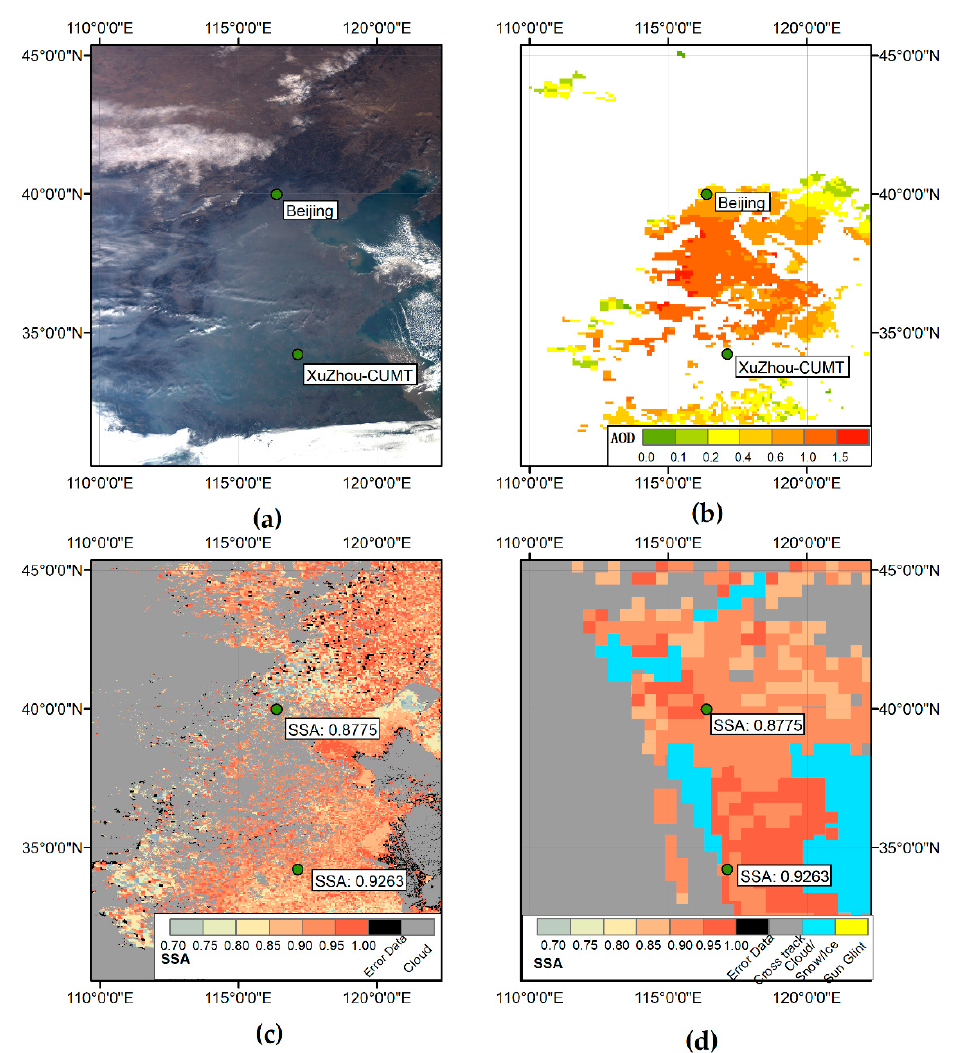
Figure 11. ( a ) True color composite map from MODIS (data came from Terra in North China Plain on 1 January 2019), ( b ) AOD map of MOD04, ( c ) SSA retrieval value of our method, ( d ) SSA retrieval value of OMAERUV. The locations and inversion SSA values of Beijing and XuZhou-CUMT sites are marked in figures.